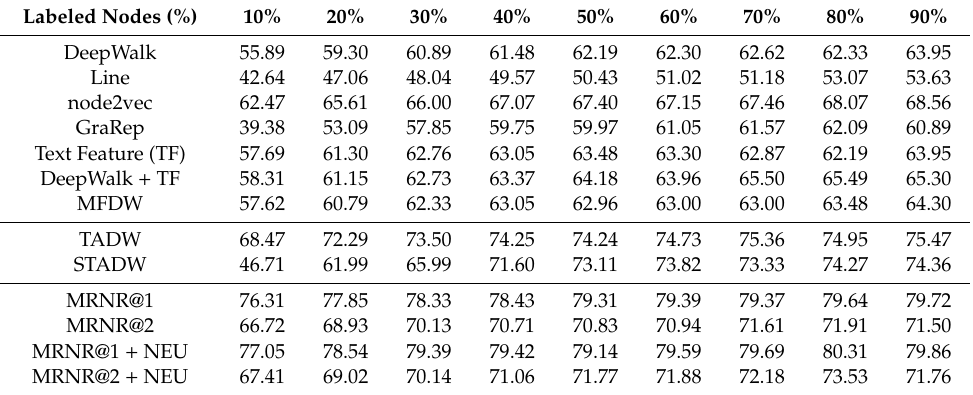
Table 4. Accuracy (%) of vertex classification on the Citeseer dataset.